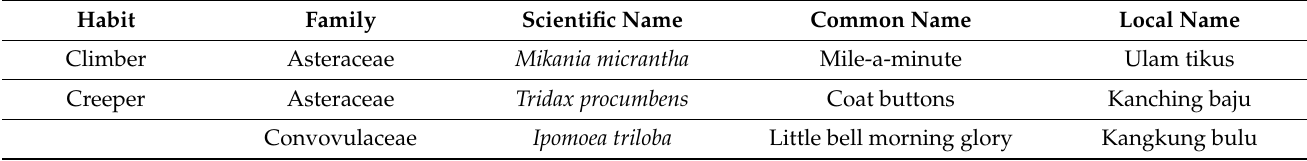
Table 3. Descriptions of weeds identified at Puchong site